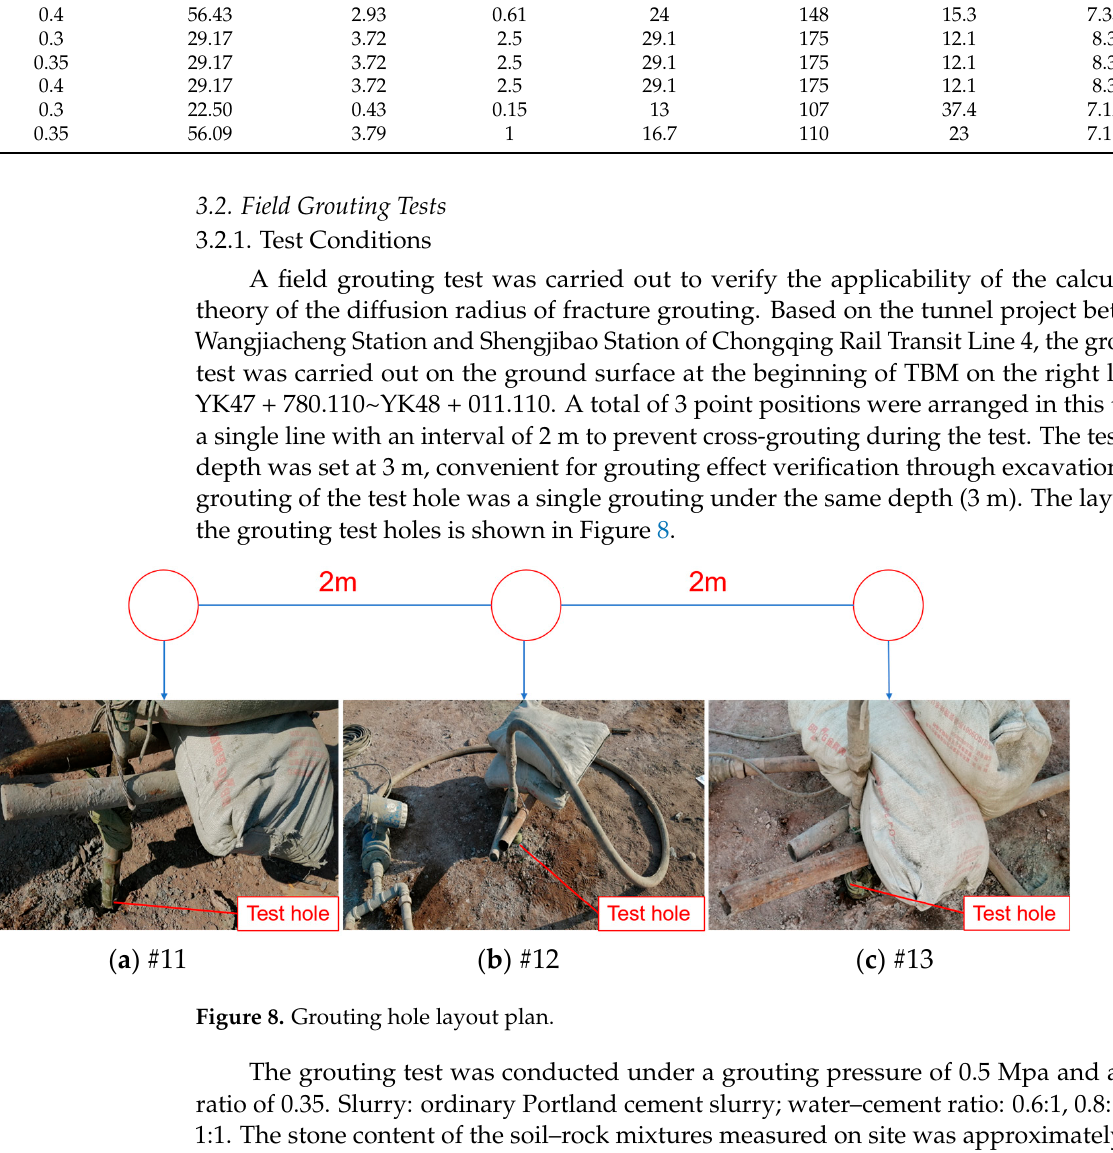
Table 2. Injected media parameters.